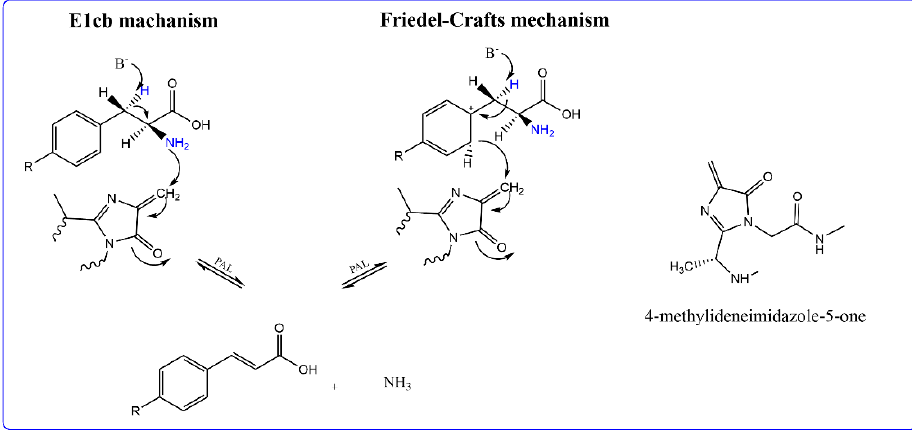
Figure 2. Reaction mechanism of PAL and the chemical structure of MIO cofactor.